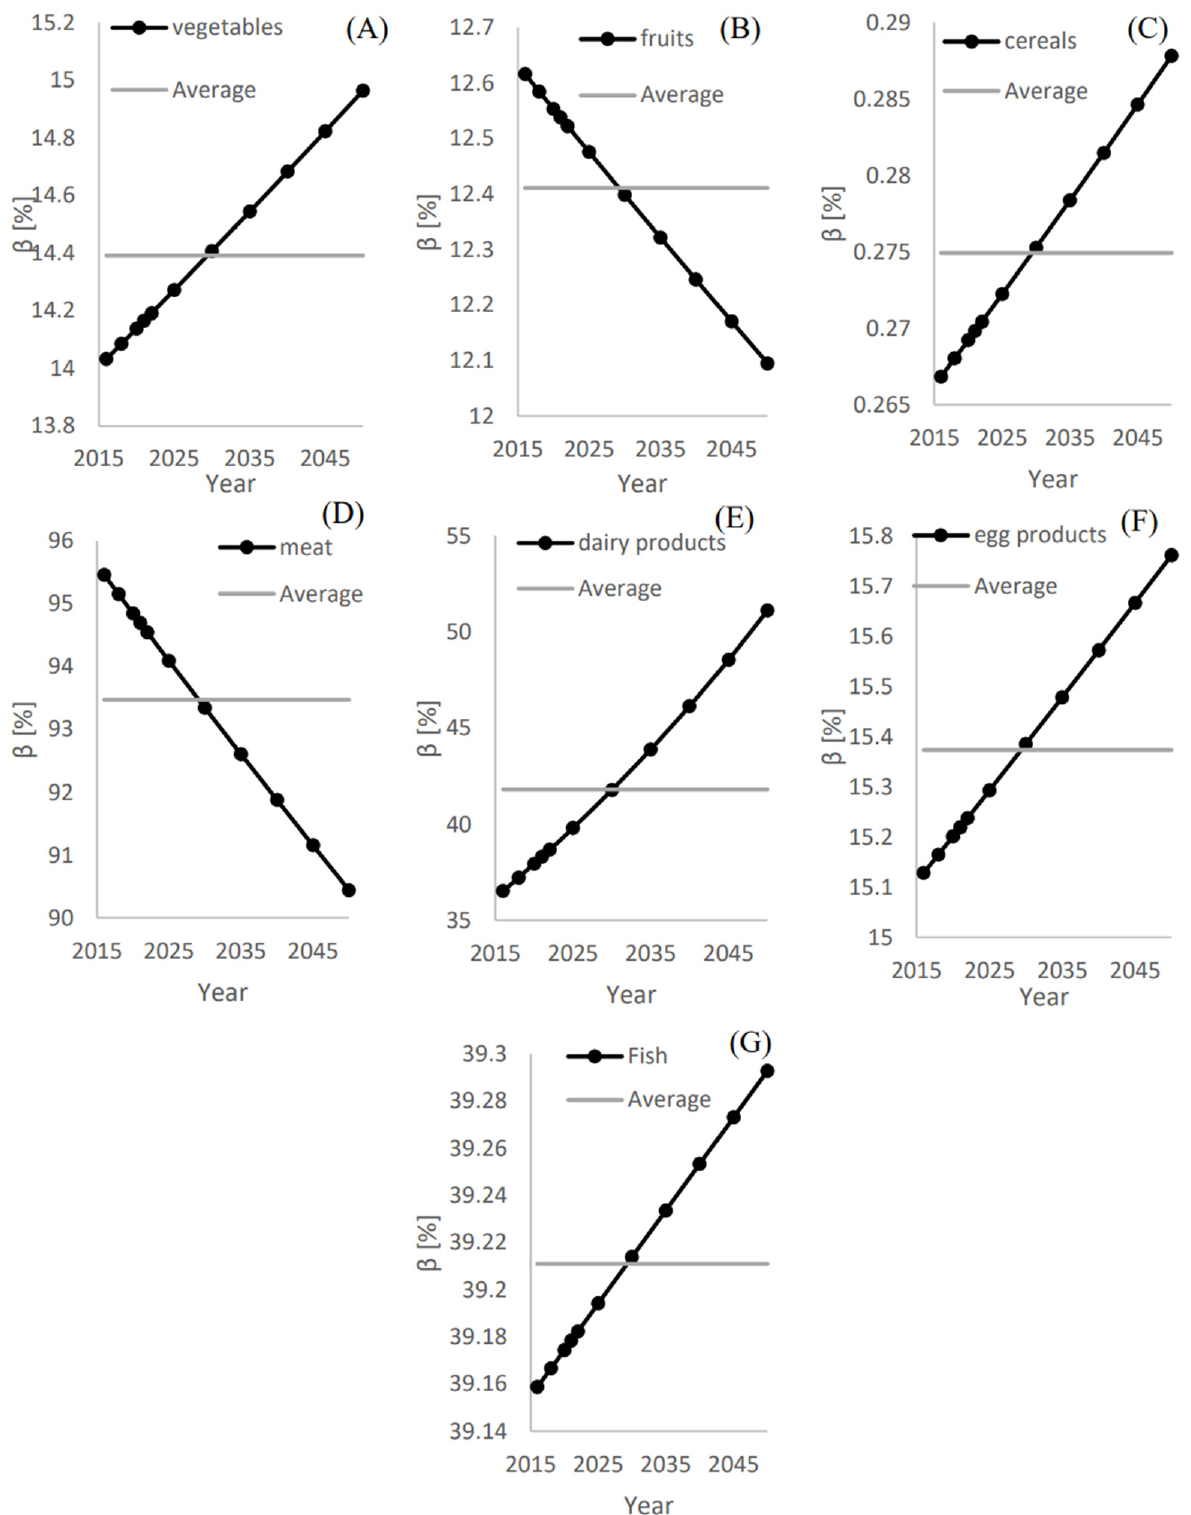
Figure 7. The annual and average ratios of the local food supply to the international supply ( β i ) and ( β(cid:3364) ) for ( A ) Vegetables, ( B ) Fruits, ( C ) Cereals, ( D ) Meat, ( E ) Dairy products, ( F ) Egg products and ( G ) Fish.